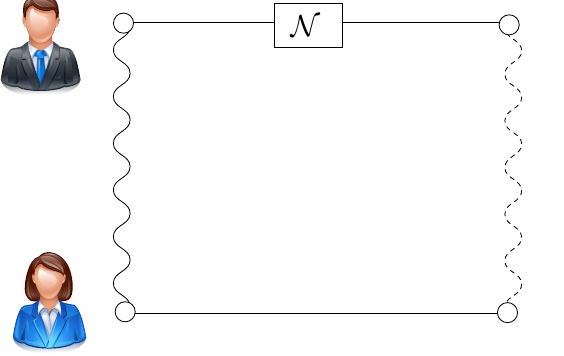
Figure 1: Single interaction scenario where N stands for local channel acting on Bob’s side.